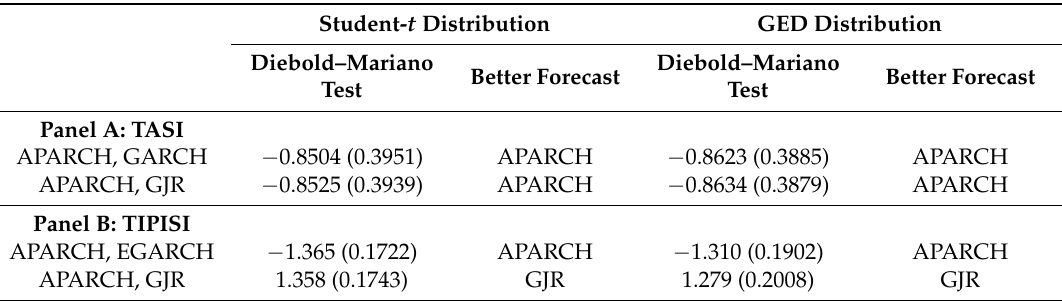
Table 8. Diebold–Mariano test for forecast comparison of the TASI and TIPISI for the full sample. The table presents the Diebold–Mariano test for the full sample (10 September 2007 to 3 August 2014) using Student- t and GED distribution. Panel A displays the Diebold–Mariano test for the TASI using Student- t and GED distribution. Panel B displays the Diebold–Mariano test for the TIPISI using Student- t and GED distribution. Numbers in parentheses are the p -values.